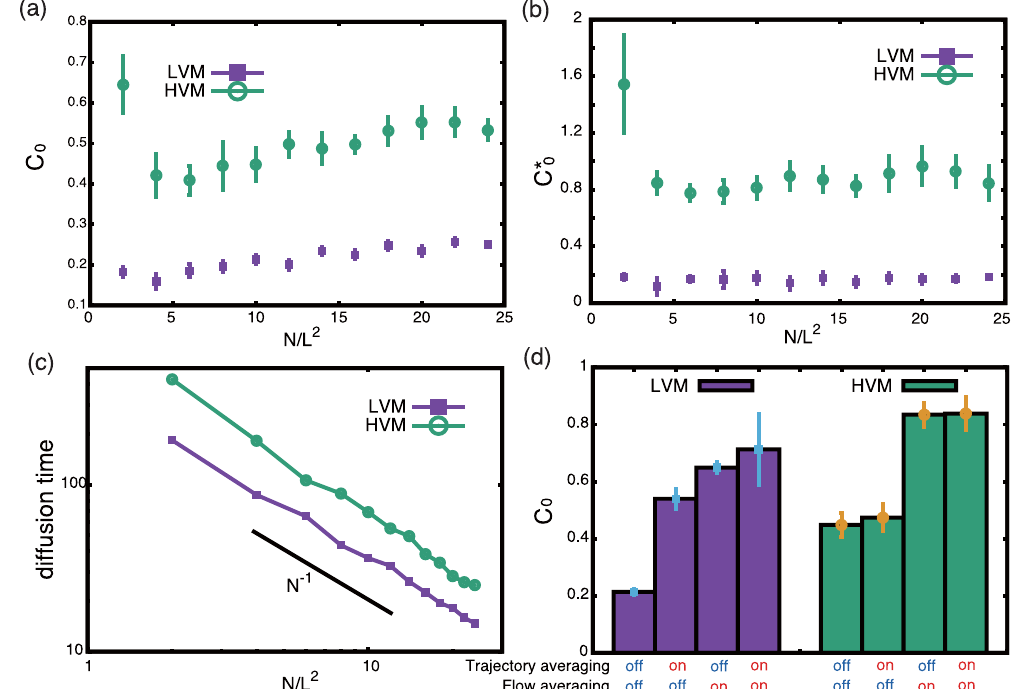
Figure 4. With a domain length of L = 5, the cell-number dependence for ( a ) the alignment order parameter C 0 , ( b ) the clustering order parameter ⁎ C and ( c ) the angular diffusion timescale. In these plots we have the end 0 time, T end , is given by 6000 for N / L 2 = 2, by 4000 for N / L 2 = 4, by 2000 for N / L 2 ∈ [6, 14] , by 1000 for N / L 2 ∈ [16, 20] and by 600 for N / L 2 ∈ [22, 24] . ( d ) The order parameter, C 0 , with all combinations of flow and trajectory averaging with L = 5, N = 250 cells and T end = 2000. The bars in plots ( a , b , d ) correspond to the 95% fitting confidence interval, as detailed in the Methods